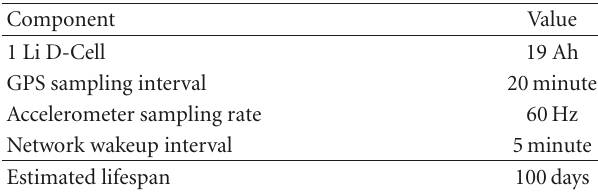
Table 2: Deployed firmware settings and battery